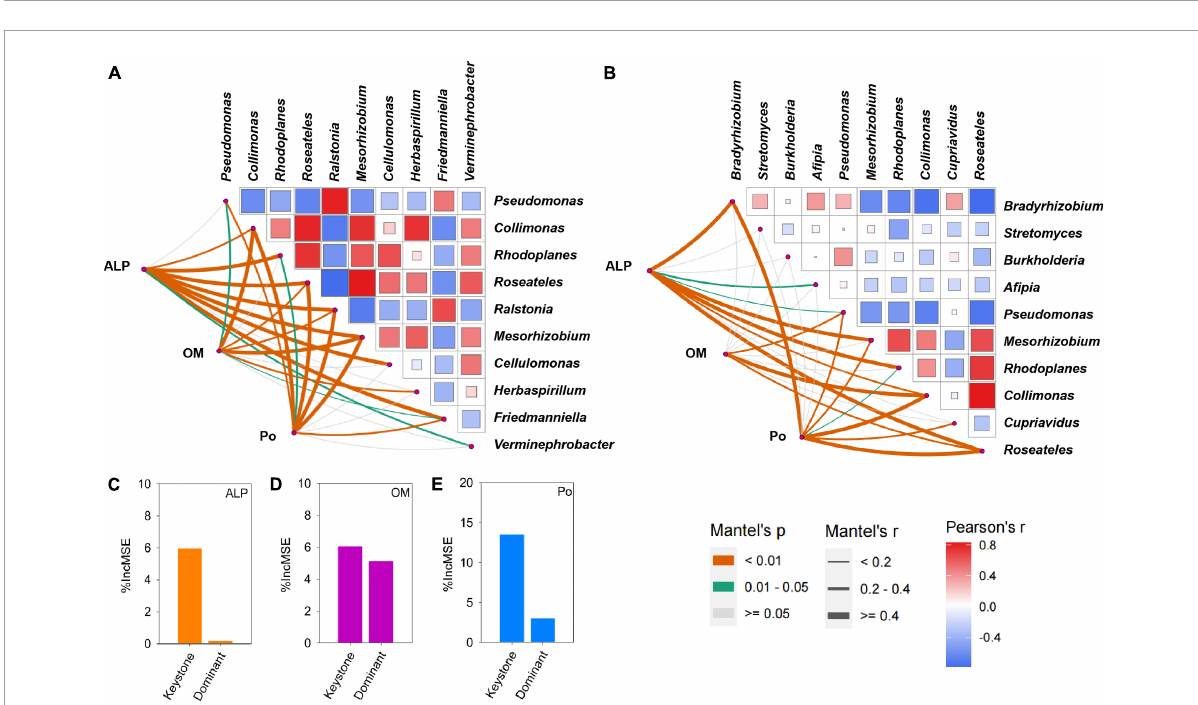
FIGURE8 Correlation among alkaline phosphatases (ALP), orthophosphate monoester (OM), and organophosphorus (Po) with the keystone (A) and dominant taxon (B) . Pairwise comparisons of the keystone and dominant taxon are separately shown in the heatmap with a color gradient to represent Spearman’s correlation coefficients. Statistically significant correlations among ALP, OM, and Po with the keystone and dominant taxon are shown in the corresponding lower left. Edge width corresponds to Mantel’s coefficients. The orange line means P < 0.01, the green line means 0.01 < P < 0.05, and the gray line means no significant effect. A random forest analysis to identify the importance of keystone taxon and dominant taxon to ALP (C) , OM (D) , and Po (E)